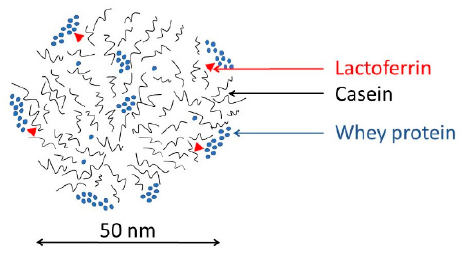
Figure 2. The scheme of a casein micelle. Reproduced from Halabi et al. [14] with permission of Elsevier .